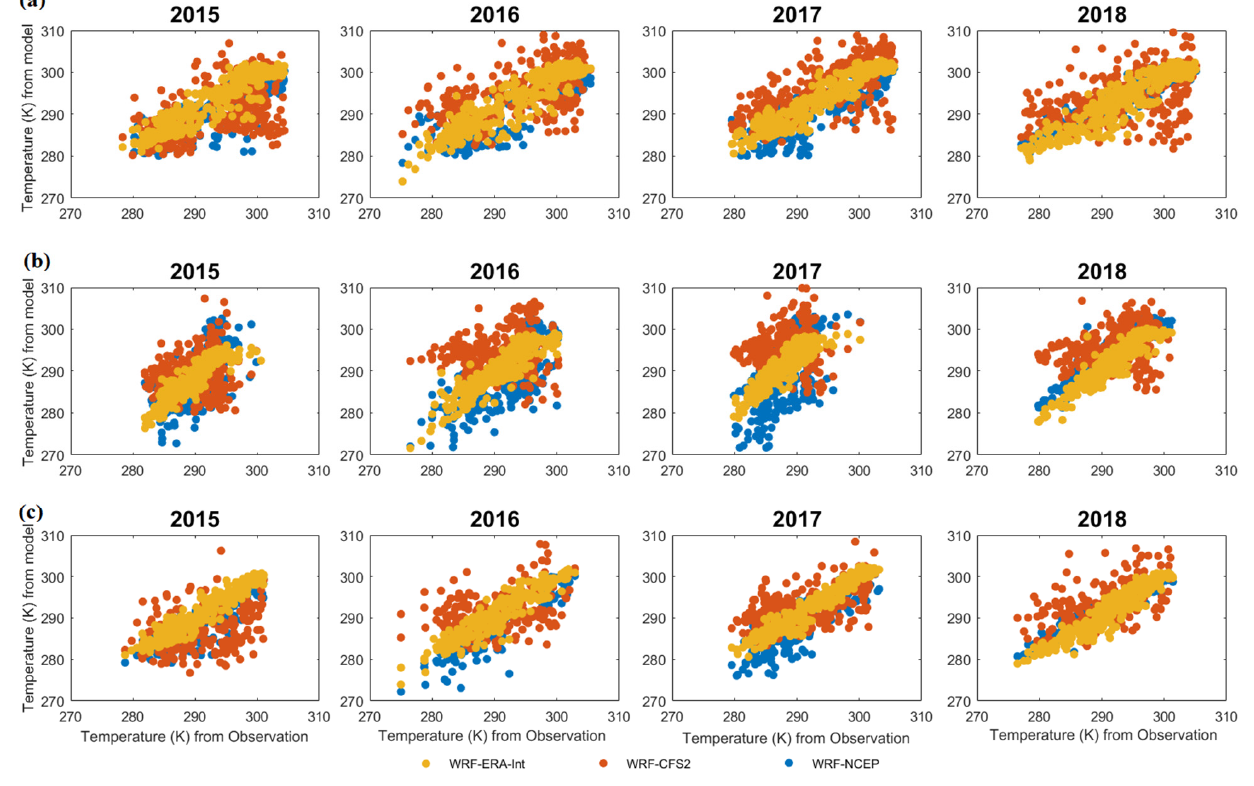
Figure 8. Daily average temperature in (unit: K) from the models and observations at the locations ( a ) Nanping, ( b ) Hong Kong, and ( c ) offshore Quanzhou.